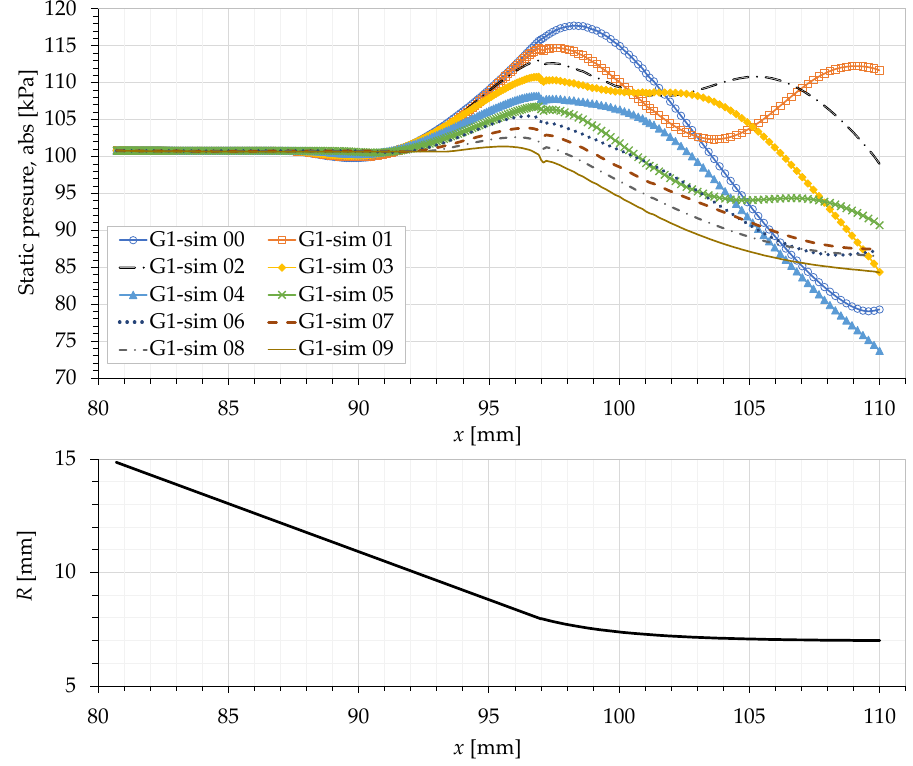
Figure 15. Pressure variation along the wall of the converging mixing section (80.7 mm ≤ x ≤ 110 mm) of ejector G1 (top) and the geometrical contour of the converging mixing section wall (bottom). The operating conditions of sim 00 to 09 can be seen in Table 3 (corresponding to simulation no. 0 to 9).